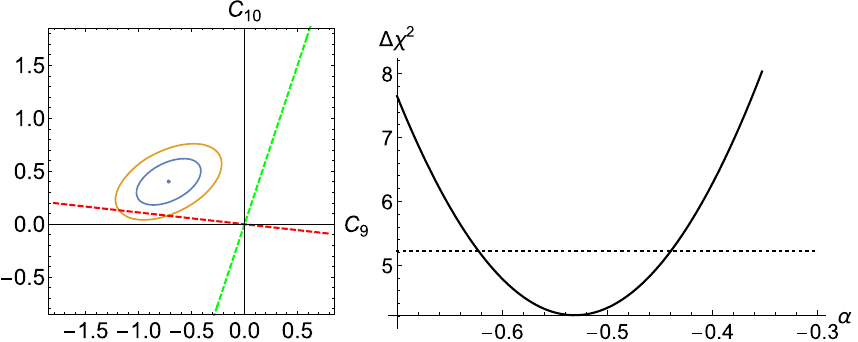
Fig. 1 Our digitisation of the fits of Ref. [17]. Left: The point shows the best-fit in ( C 9 , C 10 ) space, surrounded by 68% (inner) and 95% (outer) CL regions. The red dashed line shows the trajectory of our model, which predicts that C 9 = − 9 C 10 . We see that this ratio of Wil- soncoefficientsiscapableoffittingtheNCBAdataatthe1 . 5 σ level.For reference, we also include (green dashed line) the trajectory of models corresponding to the same anomaly-free charge assignment, but with